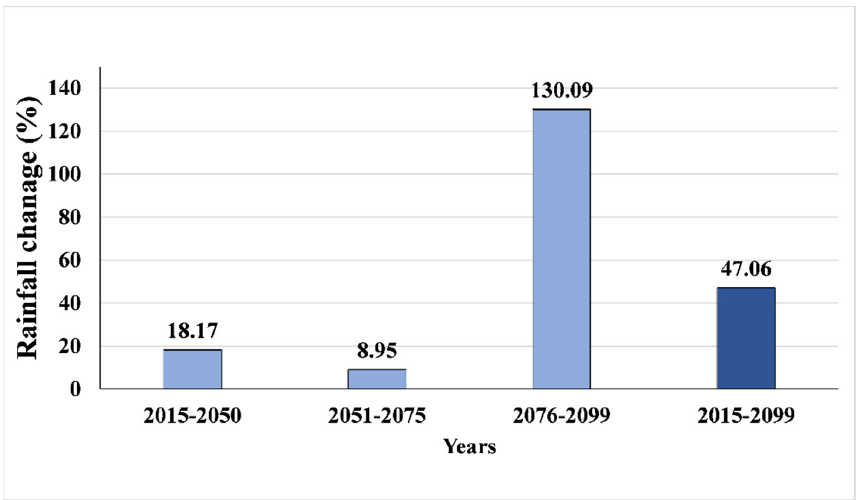
Figure 4. The rainfall changes in Egypt between the past period (1950–2014) and the future period (from 2015 to 2099), considering only the months from March to May. Spatially, the average rainfall increases in the future in all zones except the Mediter ‐ ranean Sea Coast area, which shows a decrease of about 6.25% in the future in the considered three months. Southern Egypt, Southern Upper Egypt, and the Eastern Desert show a significant increase in rainfall in the future of over 100% (Figure 5). However, we should notice that these zones in the present time did not receive enough water for the cultivation of wheat and, even if this amount was increased to over 100%, it would still not be enough. So, we should keep in mind that all agricultural areas in Egypt depend on irrigation.